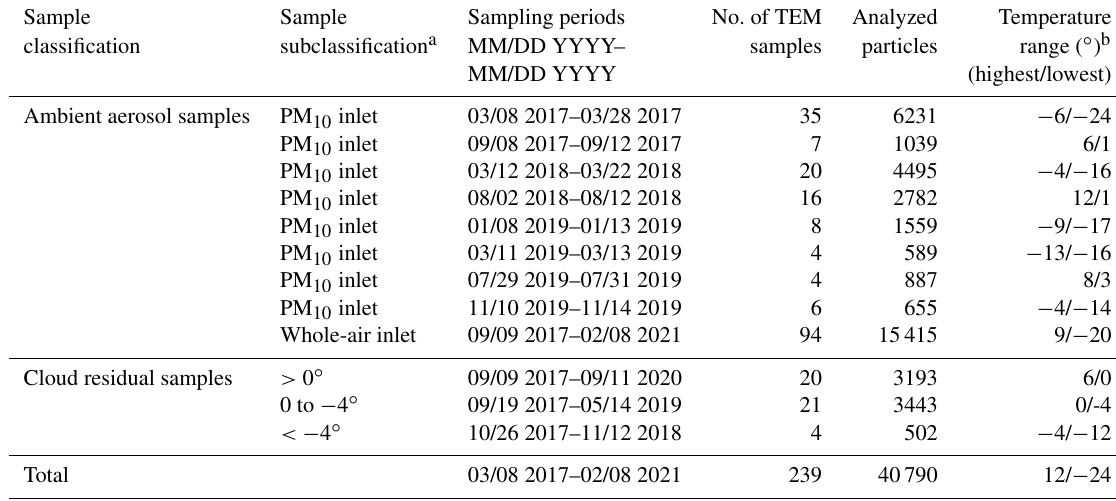
Table 1. Detailed information of all samples used in this